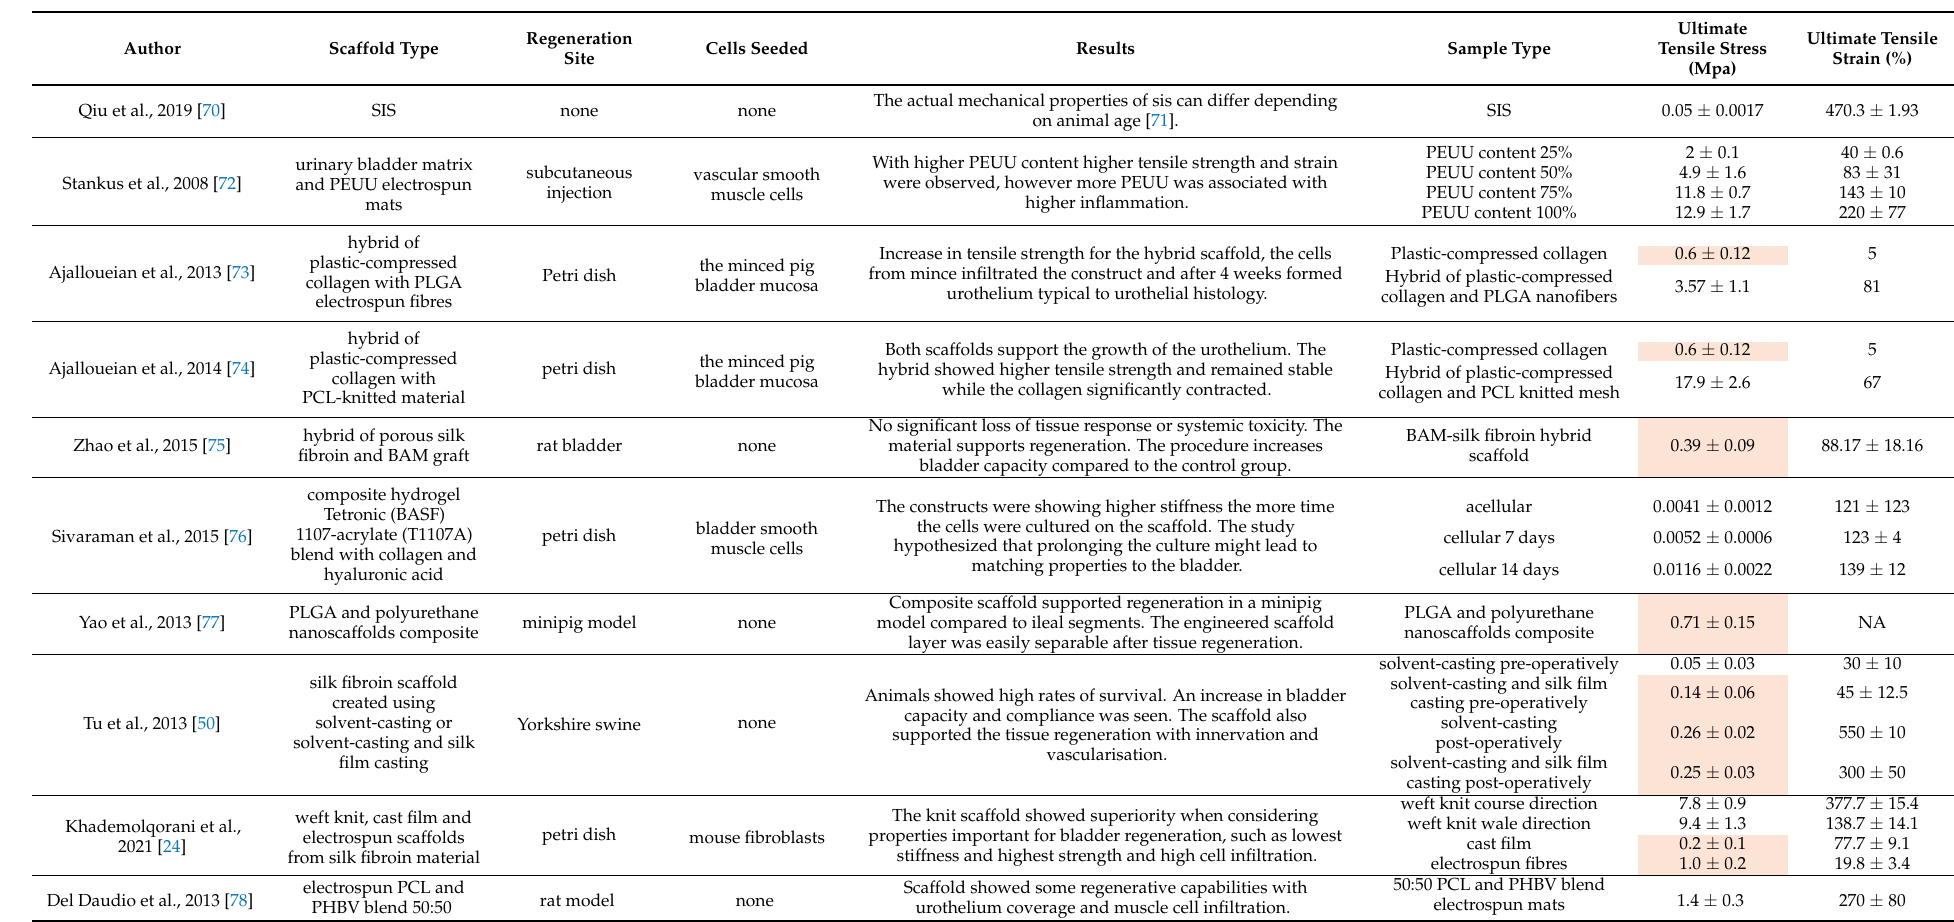
Table 2. Represents data extracted from the previously performed mechanical tests on biomaterials. All the results were obtained from uniaxial testing. The values matching the native properties of the bladder wall are highlighted in